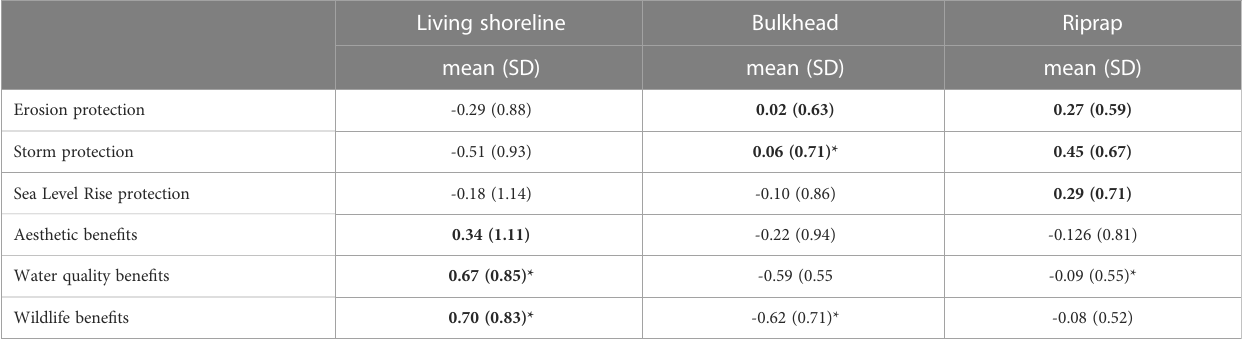
TABLE 6 Mean perception of ecosystem